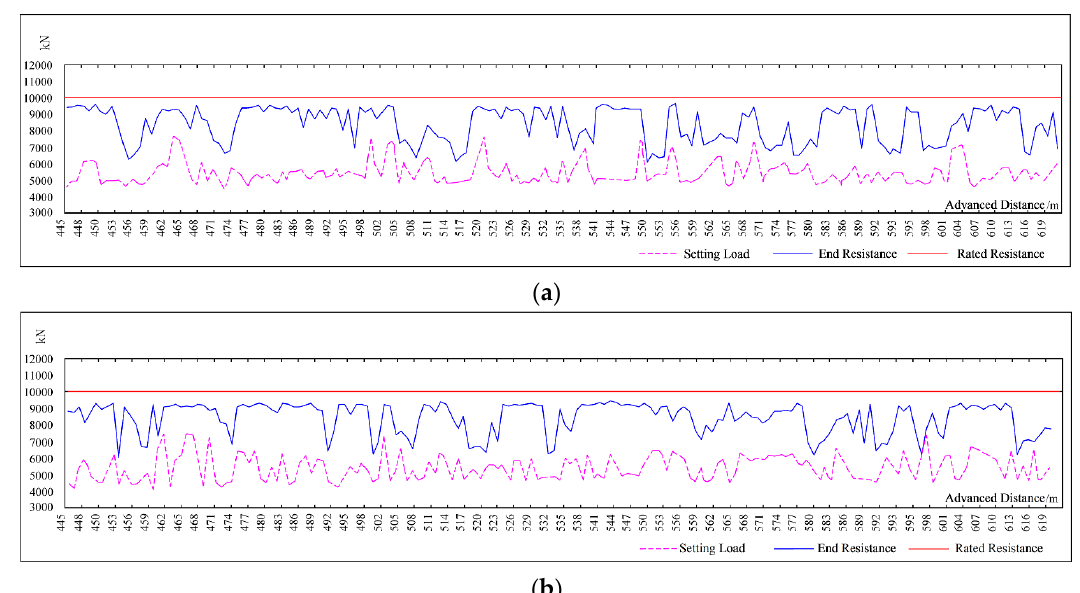
Figure 7. Distribution of support working resistance at normal mining stage measured by ( a ) No. 25 and ( b ) No. 60 monitoring unit.